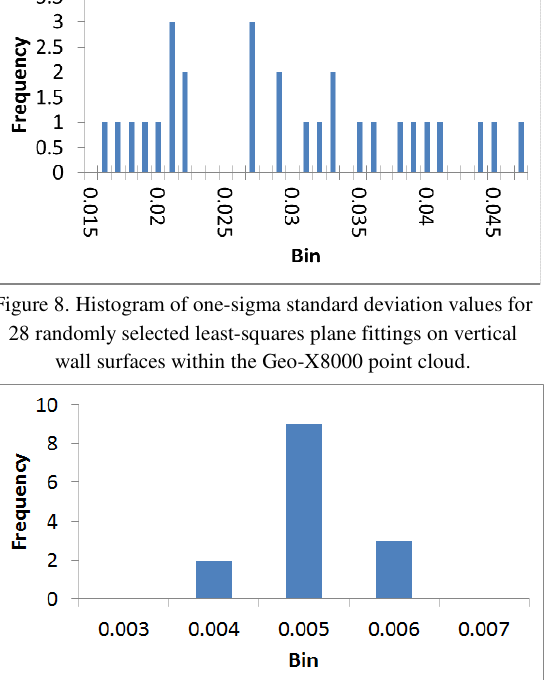
Figure 9. Histogram of one-sigma standard deviation values for 14 randomly selected least-squares plane fittings on horizontal ground surfaces within the Geo-X8000 point